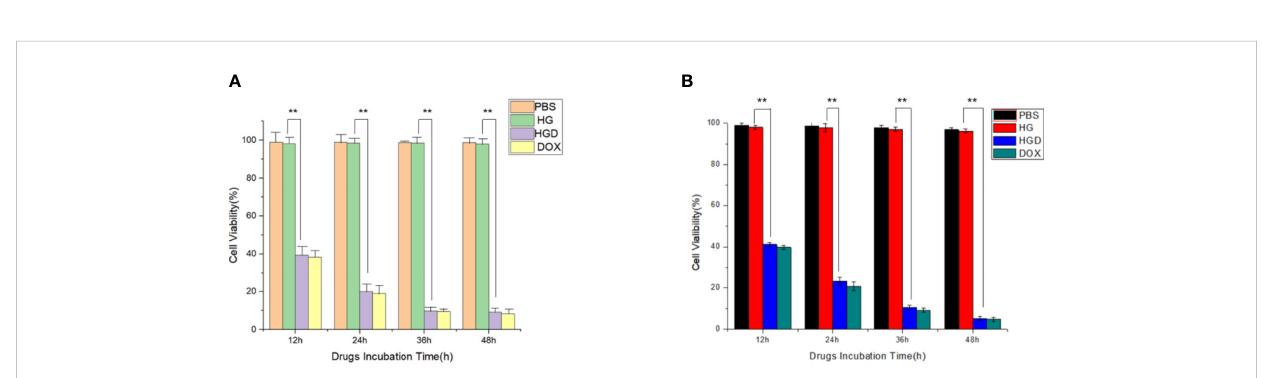
FIGURE 4 Viabilities of MCF7 (A) and MDA-MB-231 (B) after treating with 0.2 mg/ml of free DOX, HBc-GE11-DOX (equal to 0.2 mg/ml free DOX), or pure HBc VLPs for 12, 24, 36, and 48 h. **p < 0.01.